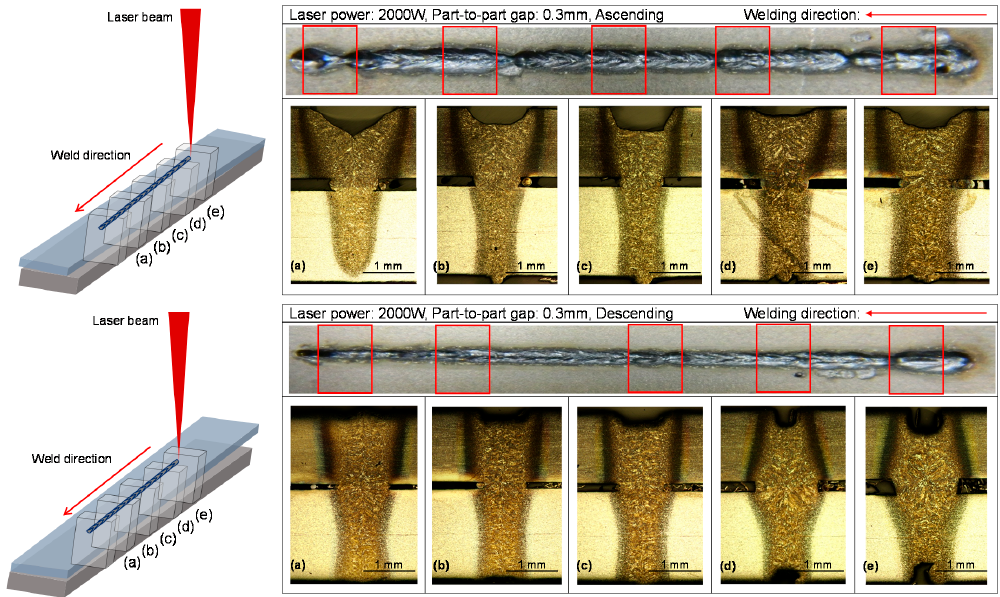
Figure 8. The lateral images of weld joints in the cases of ascending ( top ) and descending ( bottom ) travelling paths.